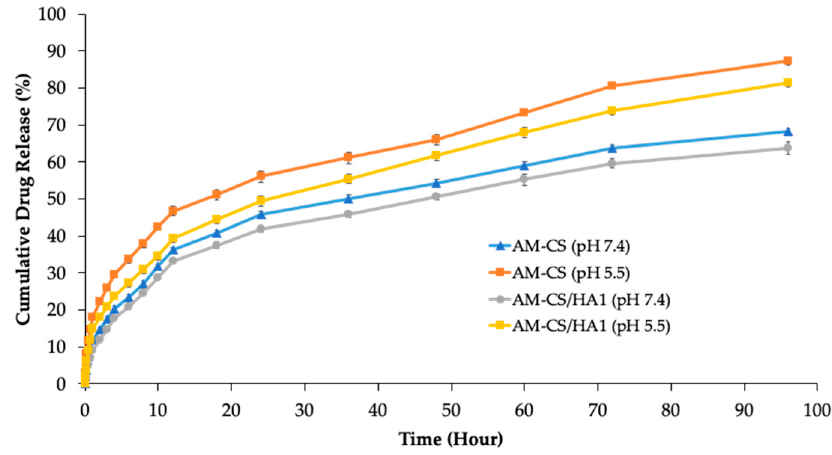
Figure 5. AM release profiles from AM-loaded nanoparticles at pH 7.4 and 5.5. Each value represents the mean ± S.E.M. Table 4. Higuchi regression parameter for AM release from AM-CS and AM-CS/HA1.